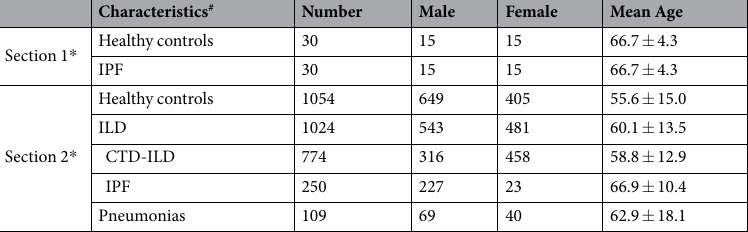
Table 1. Characteristics of the investigated subjects. * The subjects of section 1 were recruited for investigation of the ABCA3 gene by exons-sequencing; The subjects of section 2 were recruited for cohort analysis; # ILD: Interstitial lung diseases; IPF: Idiopathic pulmonary fibrosis; CTD: connective tissue